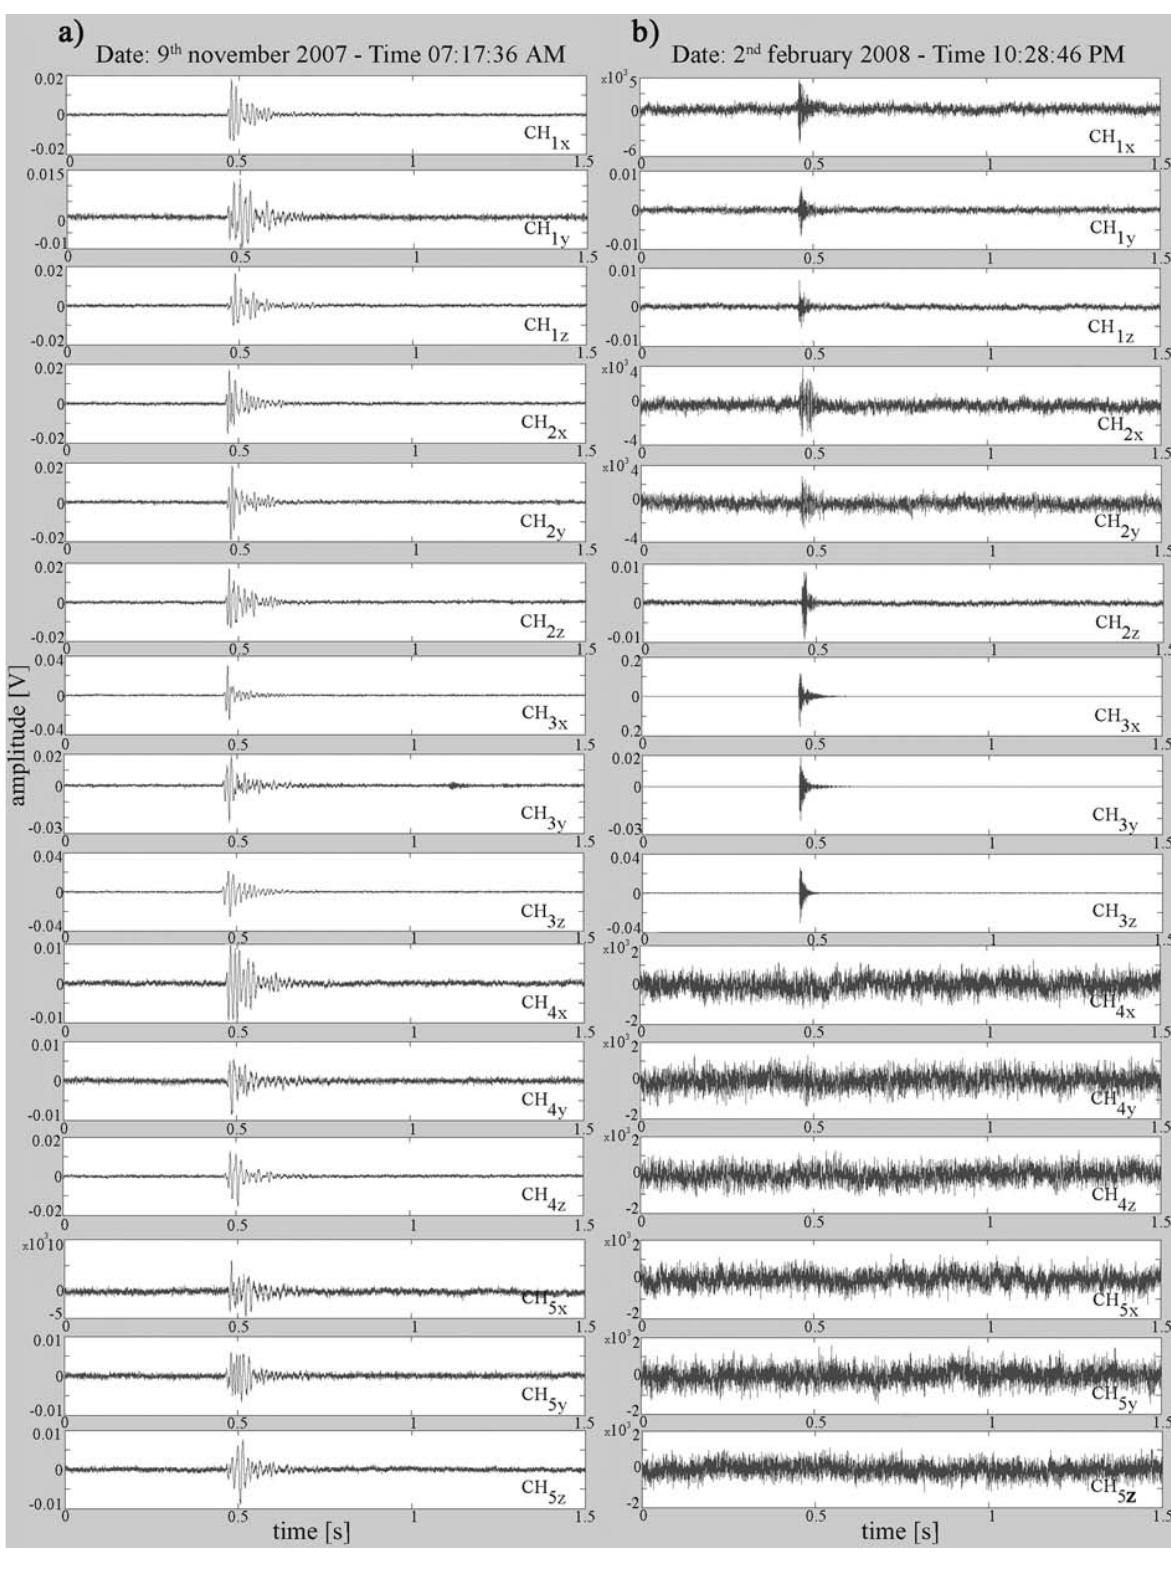
Fig. 7. Examples of recorded events: (a) event recorded with a high amplitude on all the channels; (b) event recorded with a high amplitude on only some